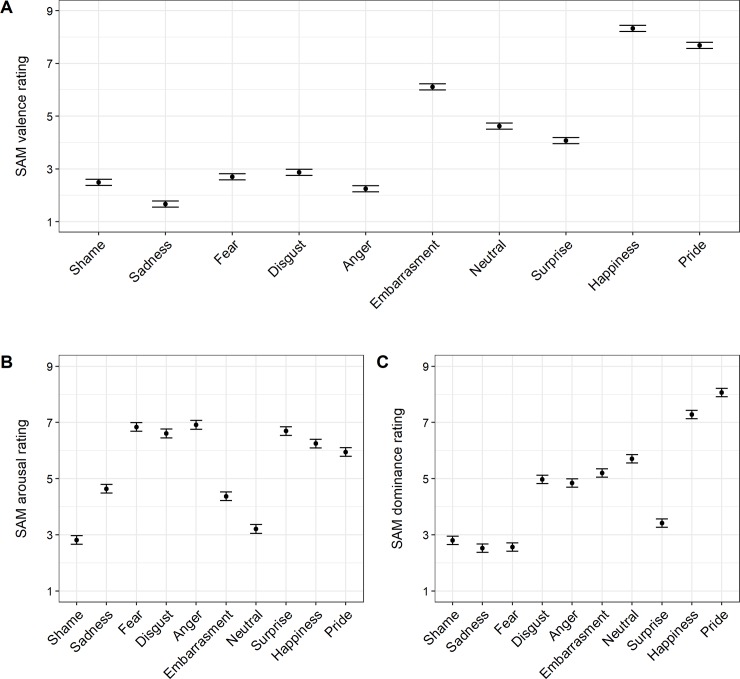
SAM Valence (A), arousal (B) and dominance (C) ratings of ten emotional expressions. Error bars reflect 95% confidence intervals of the estimated marginal means.